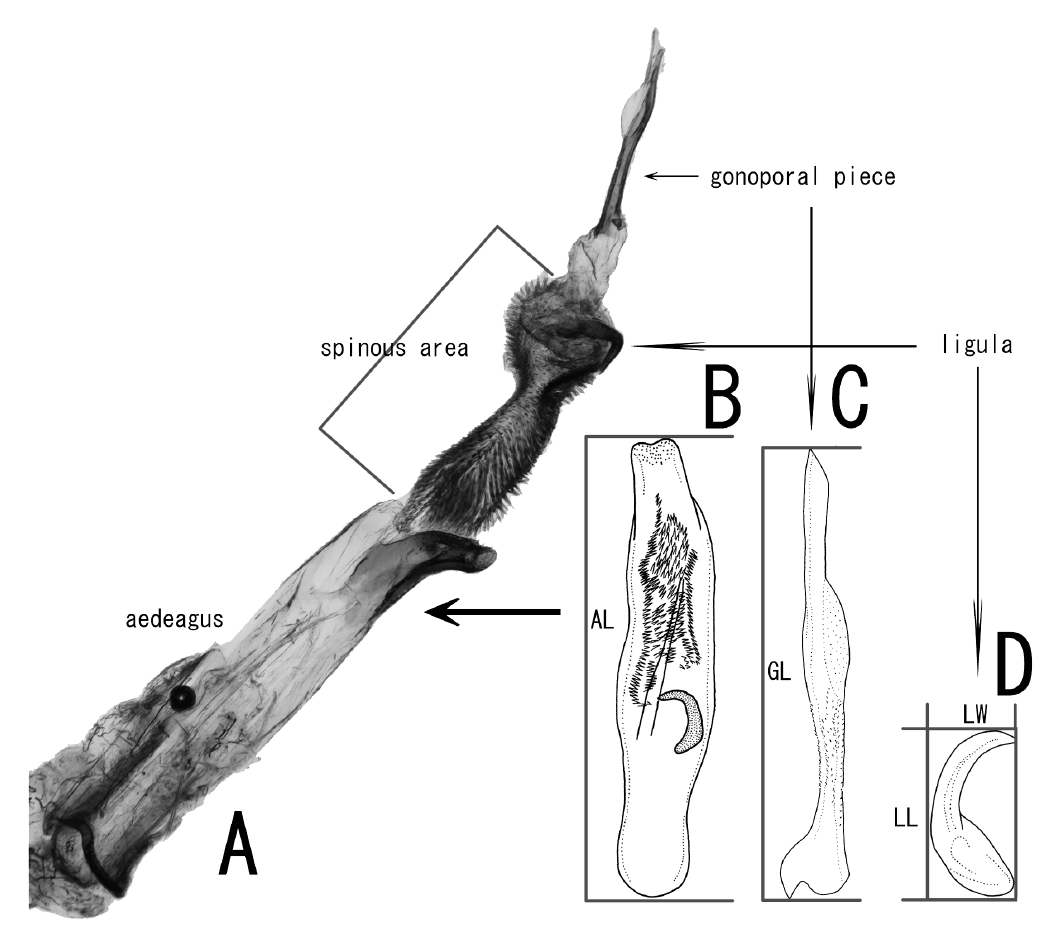
Fig. 2. Aedeagus of Laius lutaoensis Yoshitomi & Lee, 2010, showing the terminology and abbreviations for measurement of endophallic structures. A . Aedeagus with extracted endophallus. B . Aedeagus with holding endophallus (from Yoshitomi & Lee 2010). C . Gonoporal piece. D .